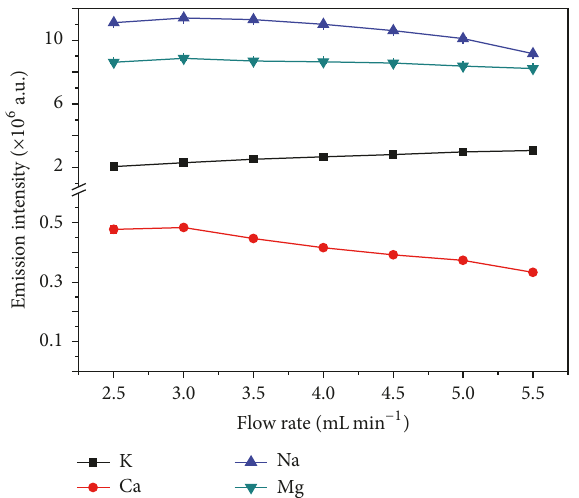
Figure 7: The effect of the solution pH on emission intensity (electrolytes:5 mg L −1 K,Ca,Na,andMgsolution,dischargevoltage: 650 V, flow rate: 3mL min −1 , interelectrode gap: 2 mm, and capillary diameter: